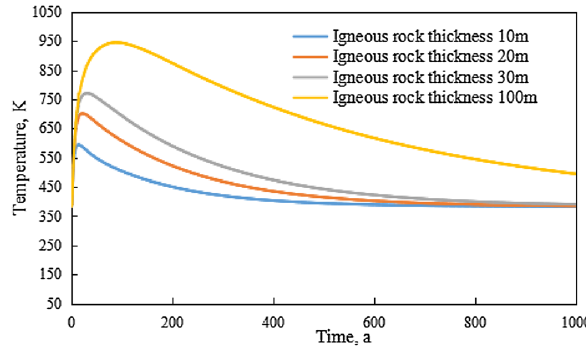
Fig. 6 Temperature curve with time at 20 m away from igneous